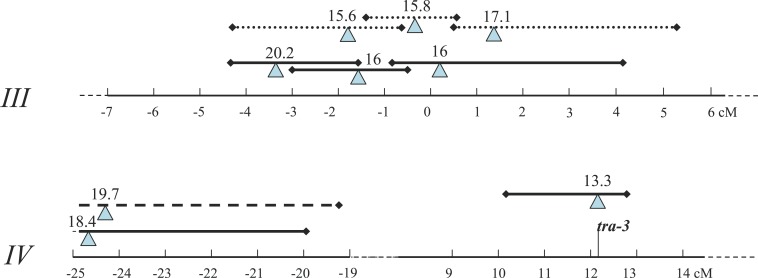
Positions of QTL Associated with Body Size and the Slope of the TRBQTL for body size at different temperatures (12 °C [dotted line] and 24 °C [dashed line]) [26] and the slope of the TRB (solid line) at Chromosomes III and IV. Triangles are the peak of the QTL and the horizontal bars are CIs. Values near the bars represent the likelihood ratio values. Only those parts of the chromosomes are shown where QTLs were detected.